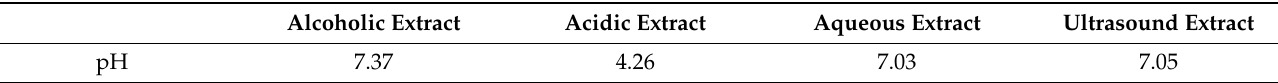
Table 2. pH values of celandine extracts.